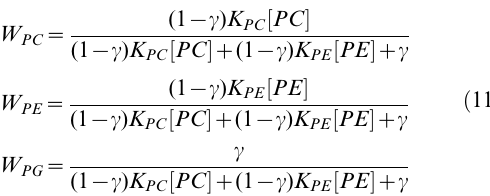
Figure S1 Trends of deviation from the IID model.